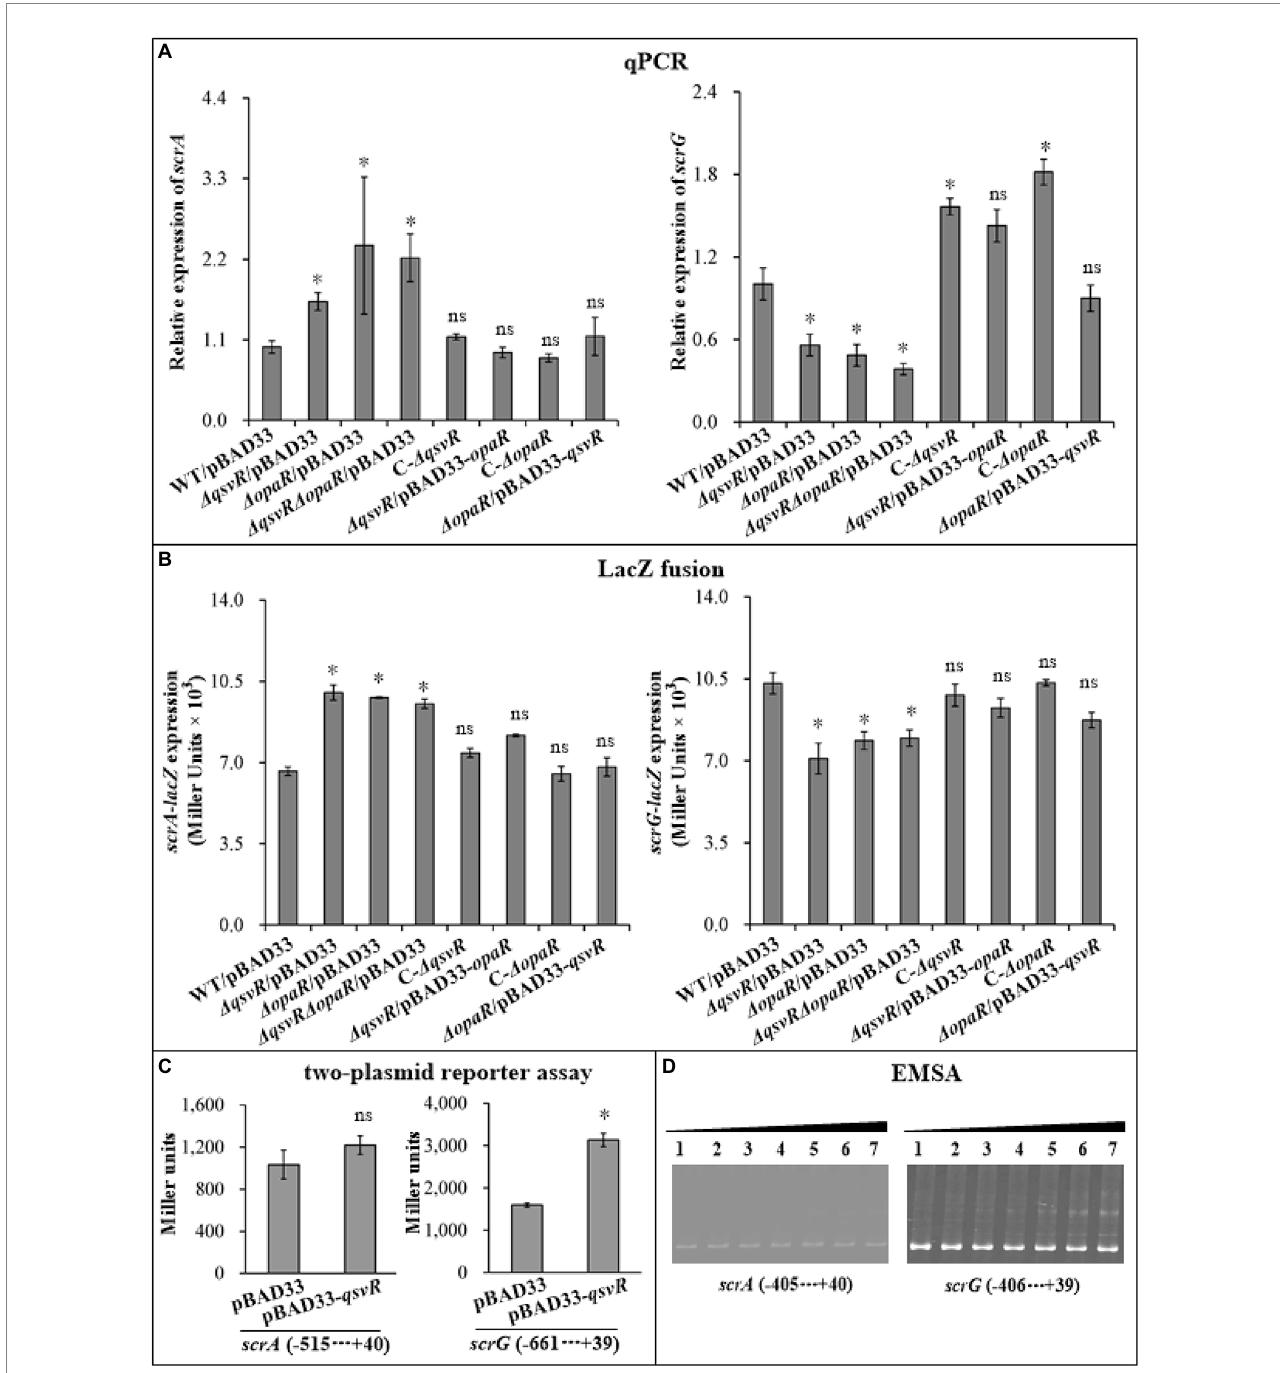
FIGURE 5 Regulation of scrG and scrA by QsvR and OpaR. qPCR (A) , LacZ fusion (B) , Two-plasmid reporter assay (C) , and EMSA (D) were carried out as described in Figure 2. Lanes 1, 2, 3, 4, 5, 6, and 7 in the EMSA (D) data contain 0, 0.021, 0.042, 0.063, 0.083, 0.11, and 0.13 pmol of His-QsvR, respectively. Negative and positive numbers indicate the nucleotide positions upstream and downstream of each target gene, respectively. The asterisks indicate statistical significances relative to WT/pBAD33 or E. coli 100 λ pir/pBAD33 ( p < 0.01). The ‘ns’ means no significant differences ( p >